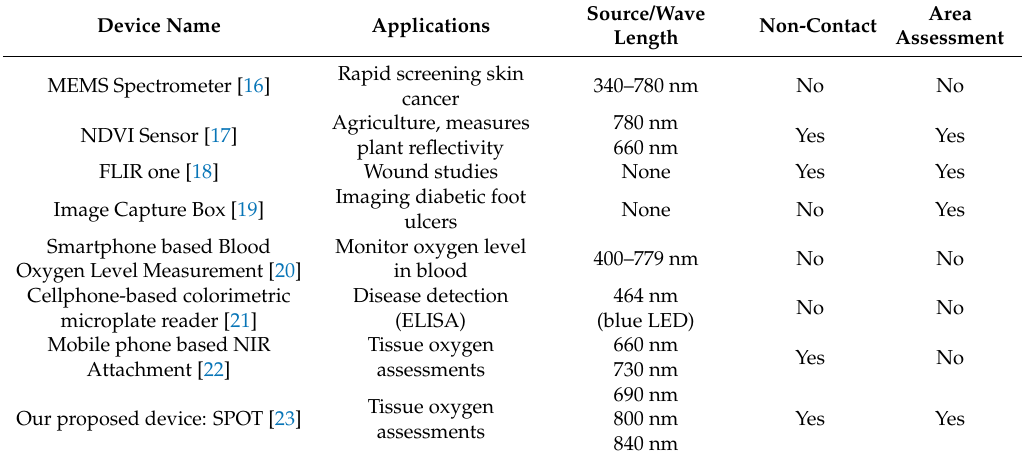
Table 1. Summary of existing cellphone-based technologies and their features/applications relevant to imaging and comparison with the proposed device. NDVI: Normalized difference vegetative index; MEMS: Micro-electro-mechanical systems; FLIR: Forward-looking infrared radiometer; NIR: Near-infrared; SPOT: Smartphone-based oxygenation